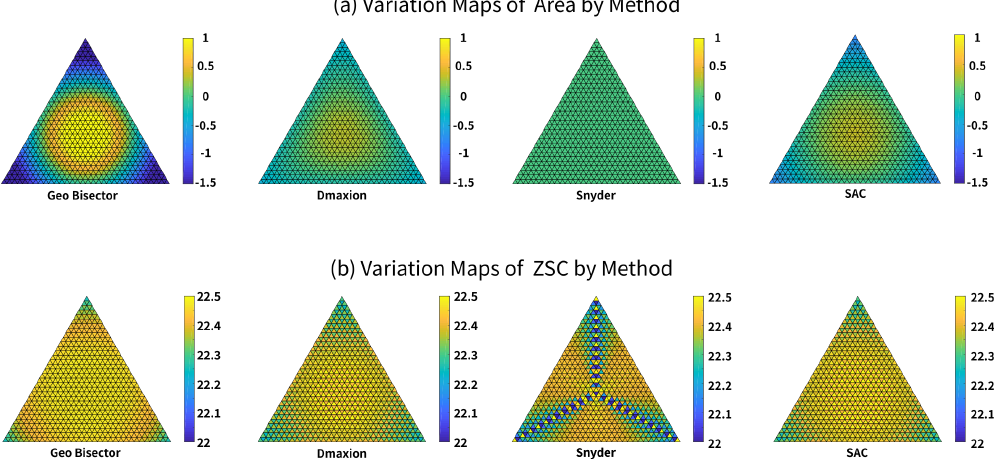
Figure 25. Maps of the spatial variation in the area and ZSC measurements for the Geo Bisector, Snyder, Dymaxion, and SAC methods for the icosahedron and 4-fold density